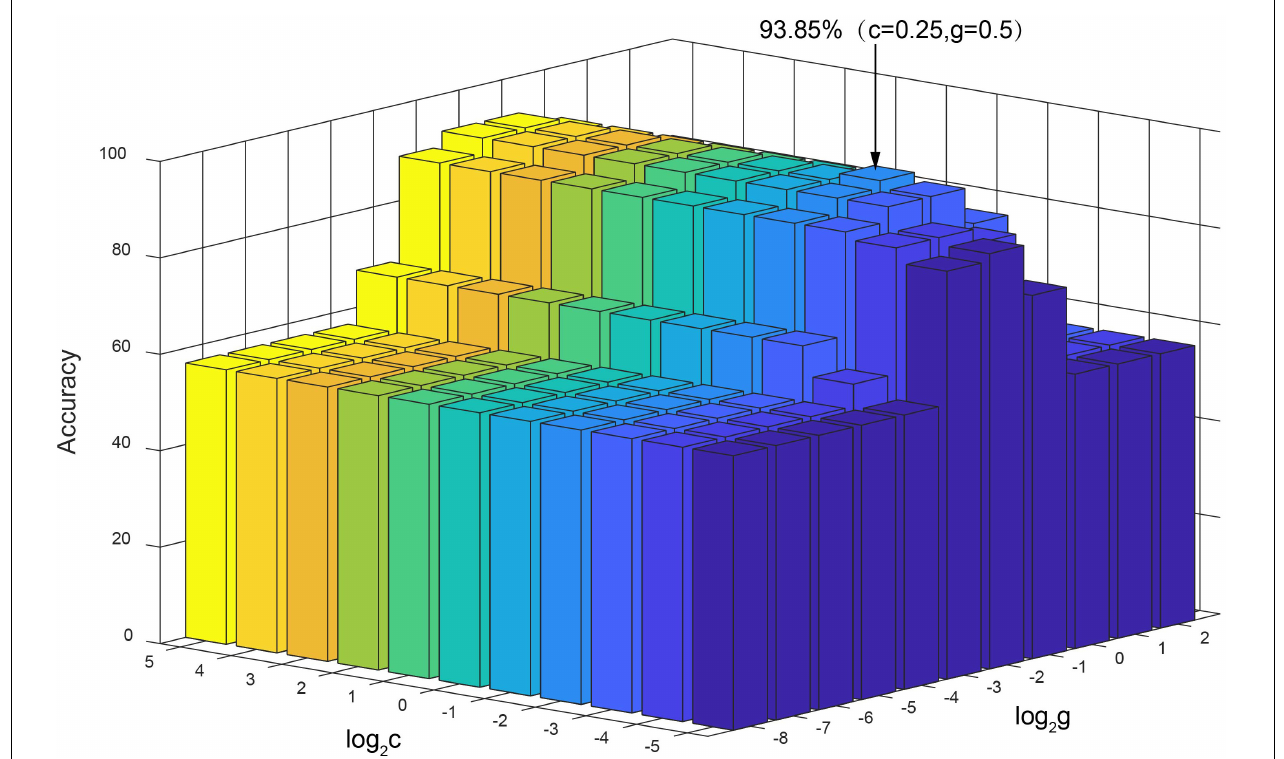
FIGURE 11 | Training classification accuracy of different SVM parameters ( c , g